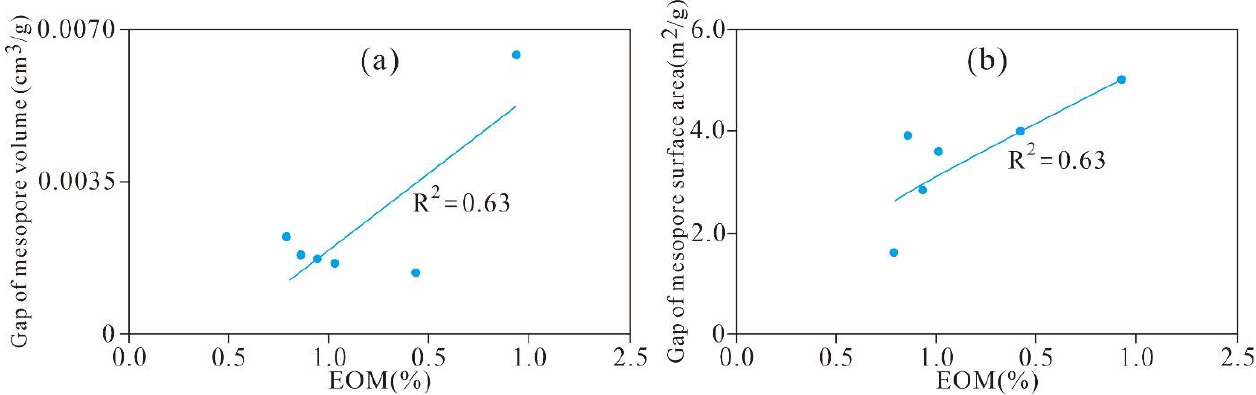
Figure 26. Relationships between the EOM and gap value of the ( a ) mesopore volume and ( b ) surface area.